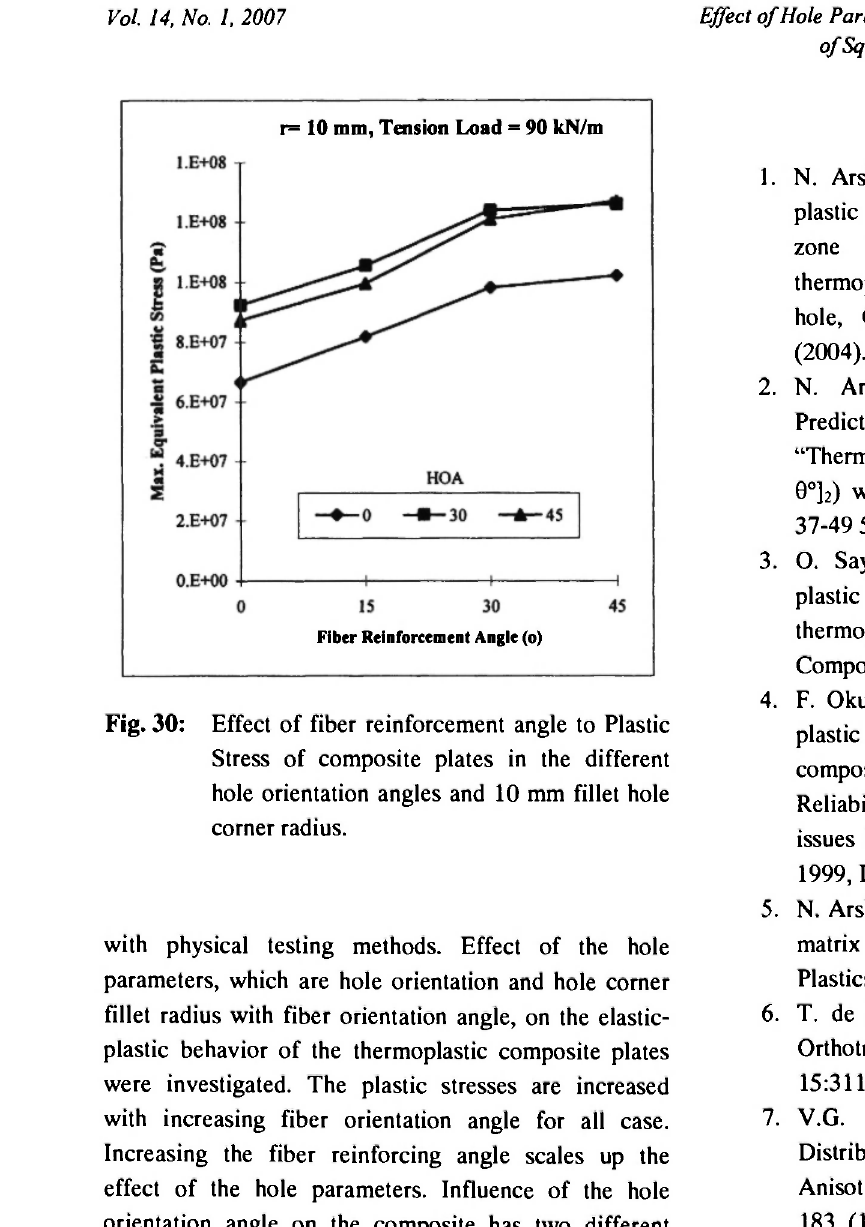
Fig. 30: Effect of fiber reinforcement angle to Plastic Stress of composite plates in the different hole orientation angles and 10 mm fillet hole corner